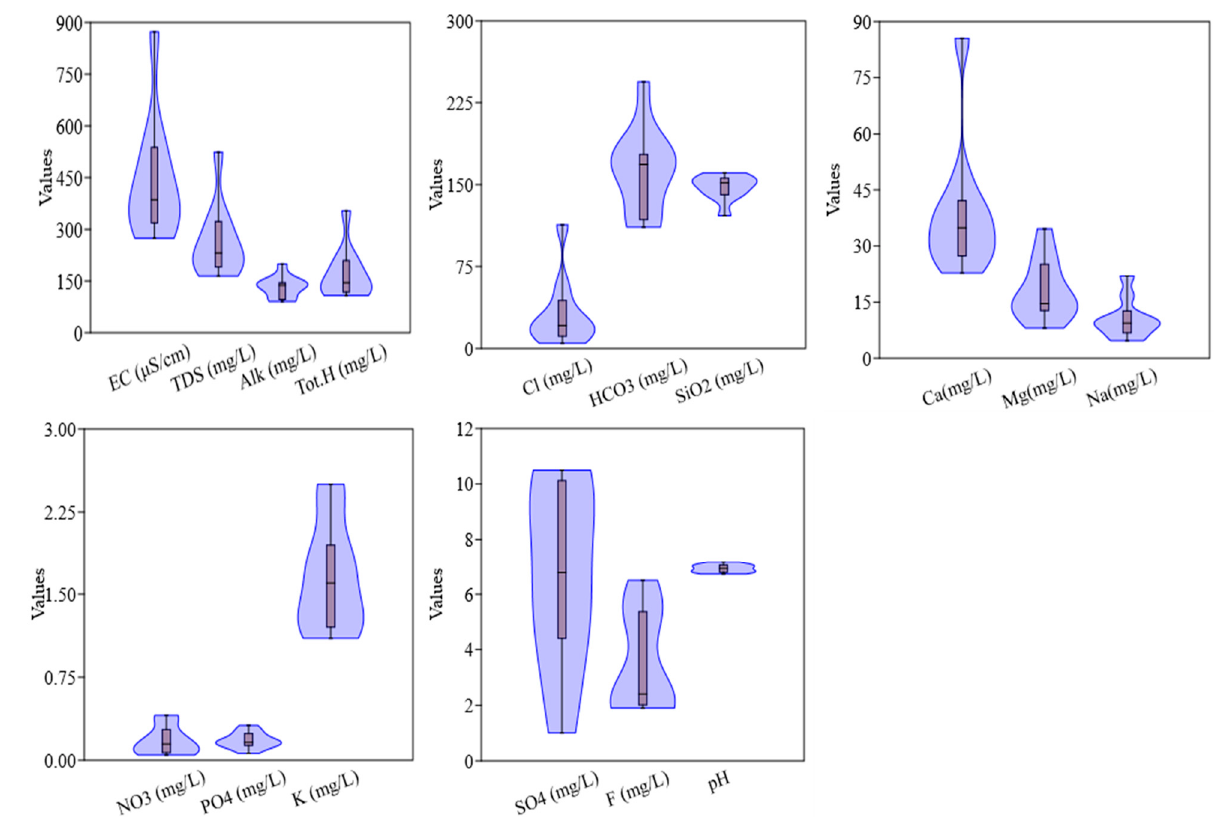
Figure 2. Violin plots of the hydrochemical parameters.